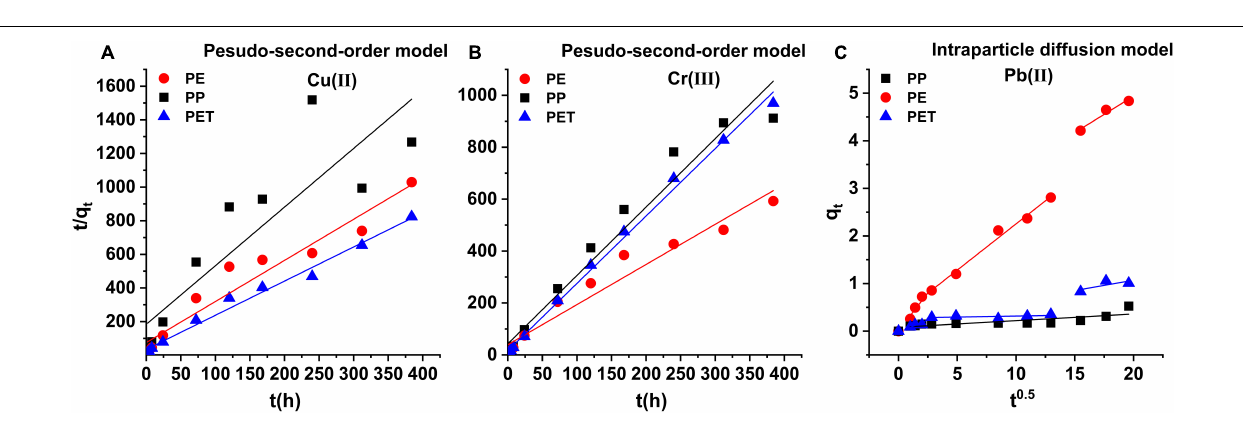
FIGURE 2 | (A) The pseudo-second-order kinetic model for Cu(II), (B) Cr(III) adsorption on PE, PP, and PET microplastics, and (C) the intra-particle diffusion model for Pb(II) adsorption on PE, PP and PET microplastics.